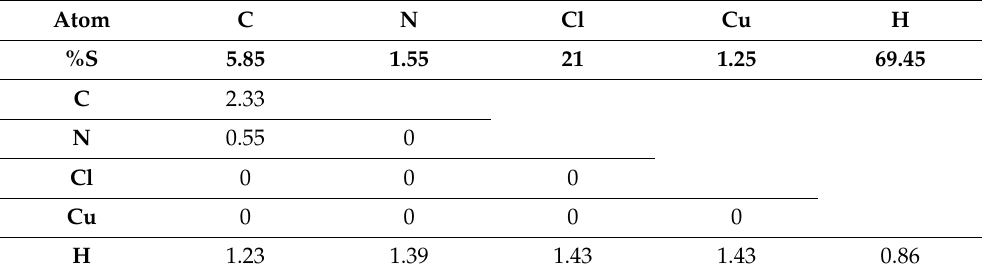
Table 5. The enrichment ratios for the title compound.